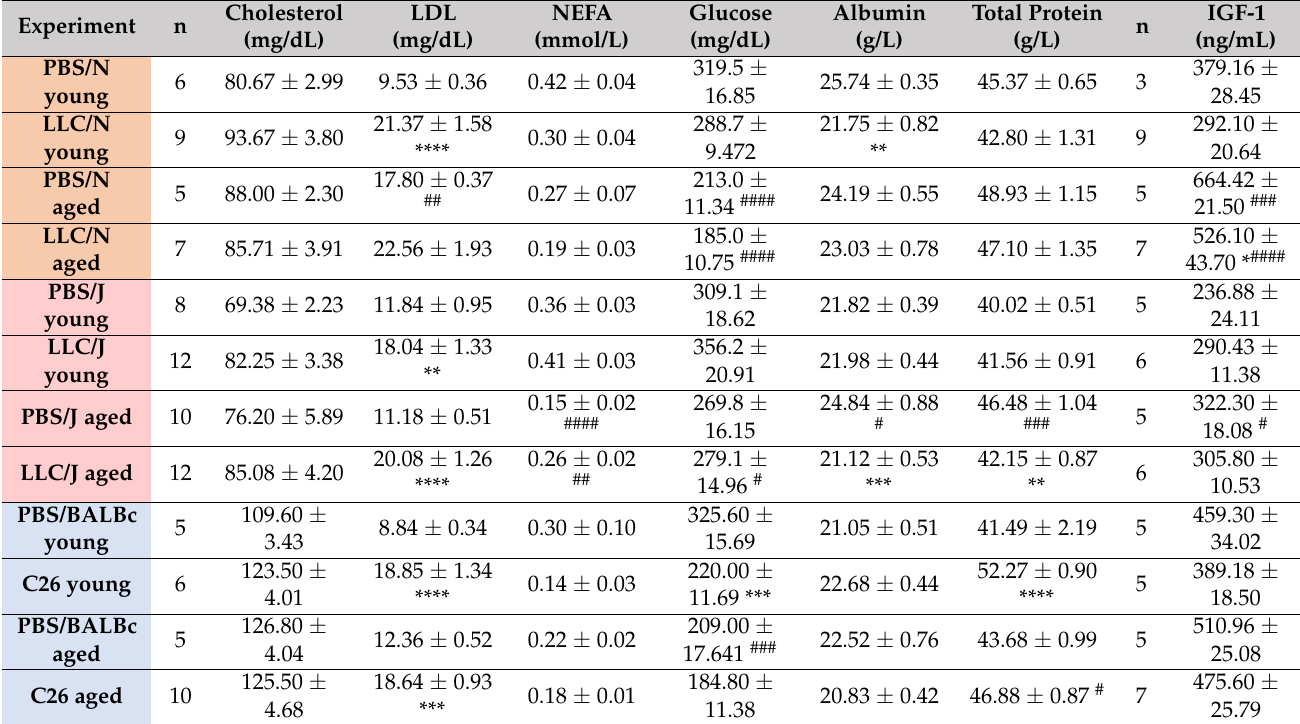
Table 1. Blood metabolites in mice are altered by tumor presence and age. Plasma levels of cholesterol, low-density lipoprotein (LDL), non-esterified fatty acids (NEFA), glucose, albumin, total protein, and insulin-like growth factor (IGF-1) in three mouse models of cachexia with groups of different age as explained in Figure 2. Data are mean ± s.e.m. Statistical analyses were performed using two-way ANOVA with Tukey’s multiple-comparison post hoc test. * p < 0.05, ** p < 0.01, *** p < 0.001, **** p < 0.0001 compared to PBS mice. # p < 0.05, ## p < 0.01, ### p < 0.001, ##### p < 0.0001